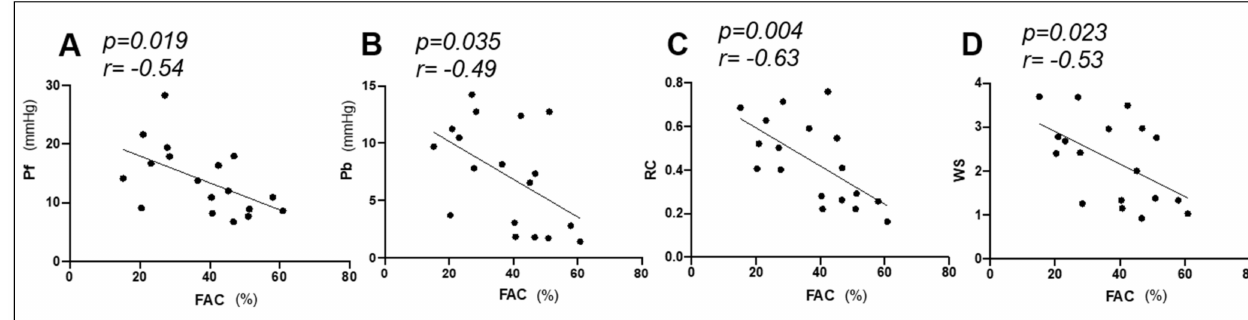
Figure 6. Correlation between pulmonary artery wave reflection (PAWR) parameters (Pf ( A ), forward-traveling pressure; Pb ( B ), backward-traveling pressure; RC ( C ), reflection coefficient; WS ( D ), wave speed) and right ventricular fractional area of change (FAC). r, the correlation coefficient. There was a significant reverse correlation between PAWR parameters (A, Pf; B, Pb; C, RC; D, WS) and FAC ( p < 0.05).